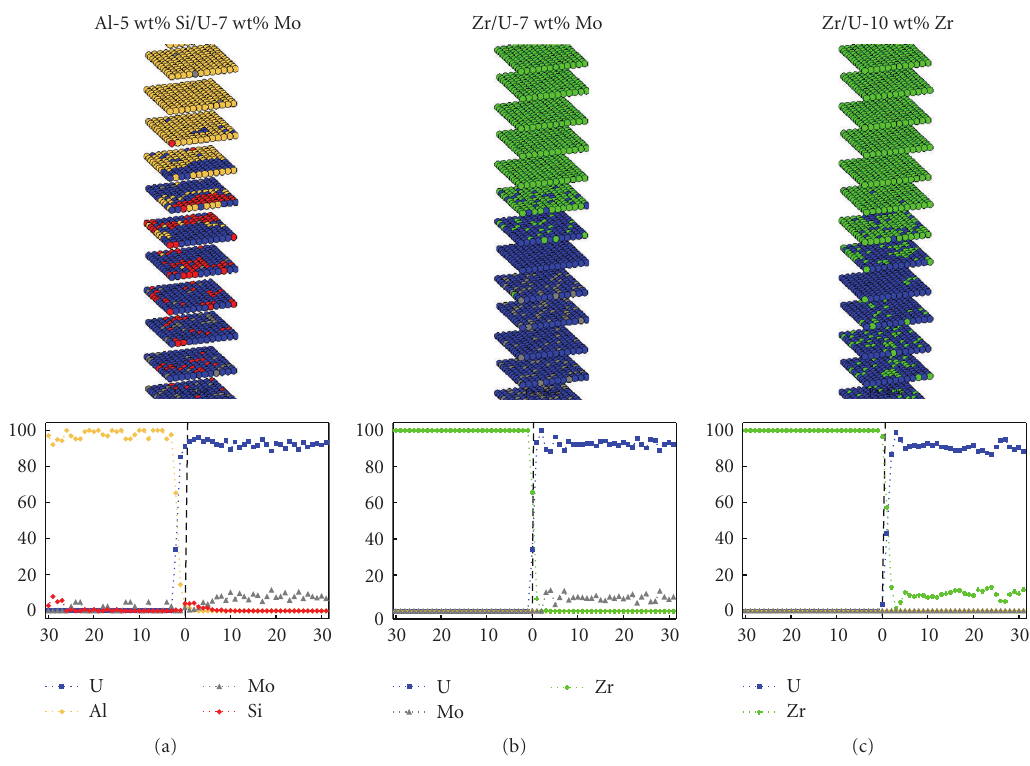
Figure 12: Equilibrium state of the computational cell at T = 550 K for (a) Al-5wt% Si/U-7 wt% Mo, (b) Zr/U-7wt% Mo, and (c) Zr/U- 10wt% Zr, and their corresponding concentration profiles (in wt%). The original location of the interface (at the onset of the simulation) corresponds to the label “0”. U, Mo, Al, and Zr atoms (and profiles) are denoted in blue, grey, yellow, and green,